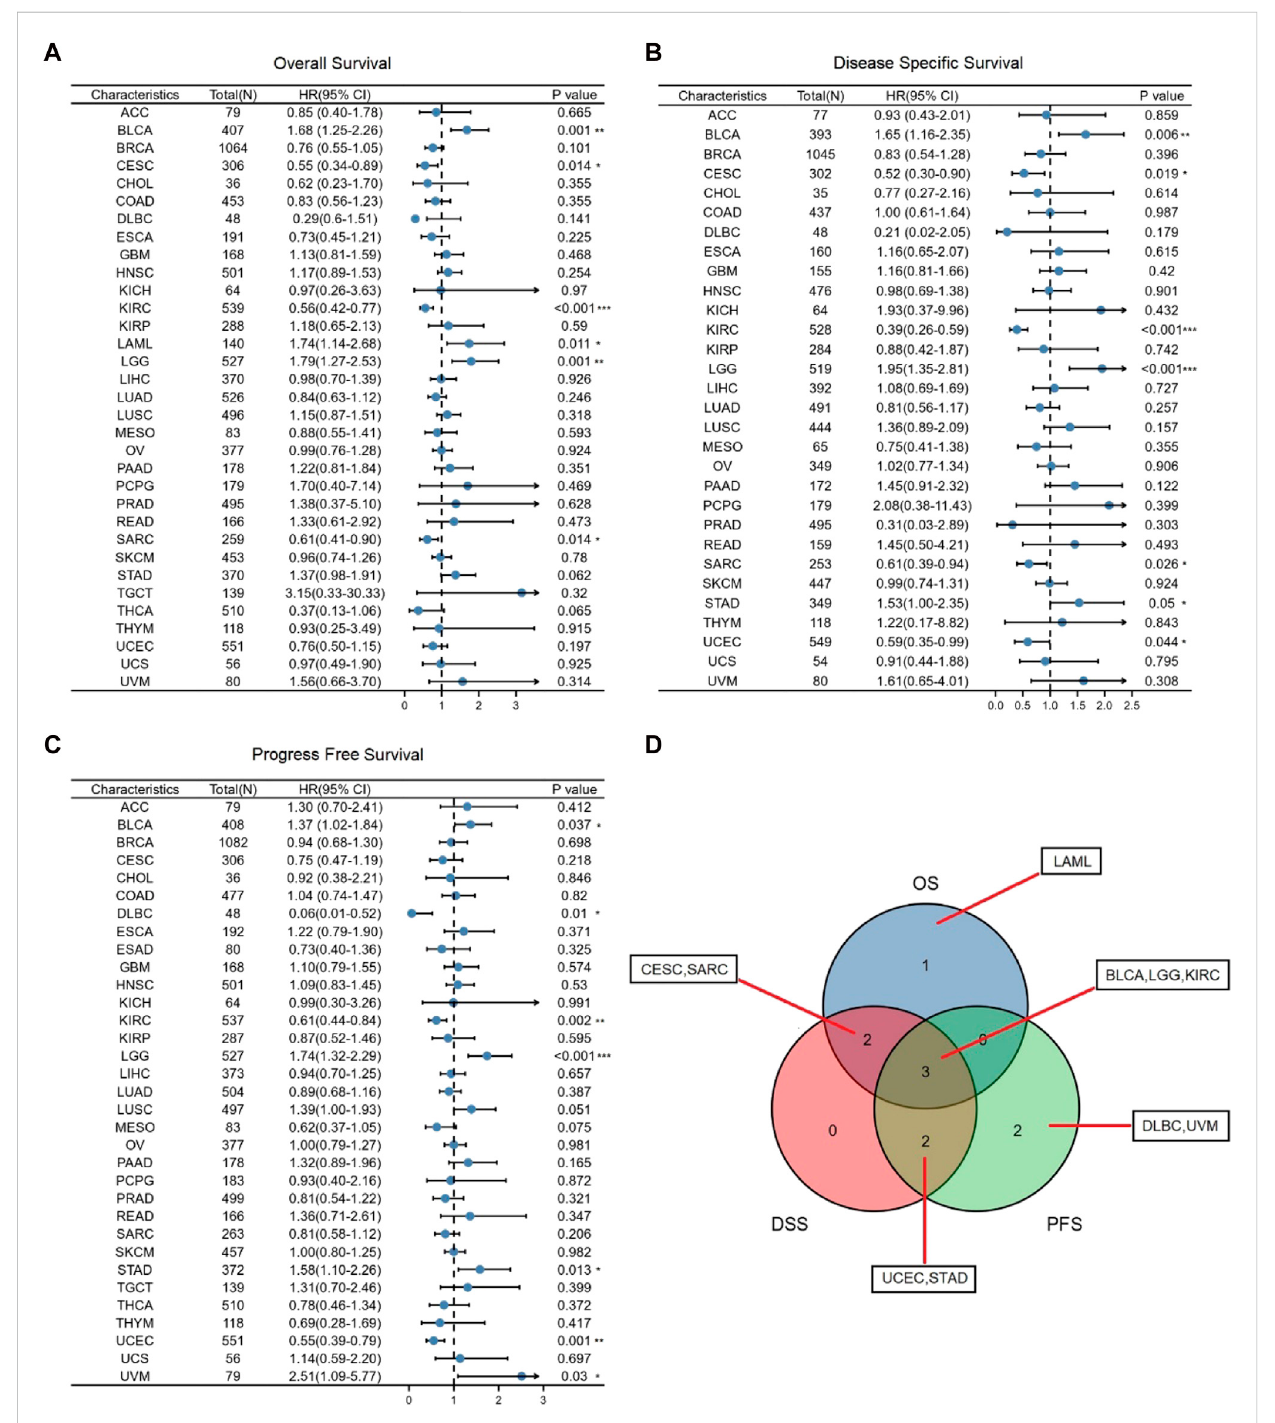
FIGURE 4 Association between GSN expression and prognosis in cancer patients. (A) Association between GSN expression and OS in cancer patients. (B) Association between GSN expression and DSS in cancer patients. (C) Association between GSN expression and PFS in cancer patients. (D) The venn diagram shows the intersection of OS, DS, PFS for different cancers. (* p < 0.05, ** p < 0.01, *** p <